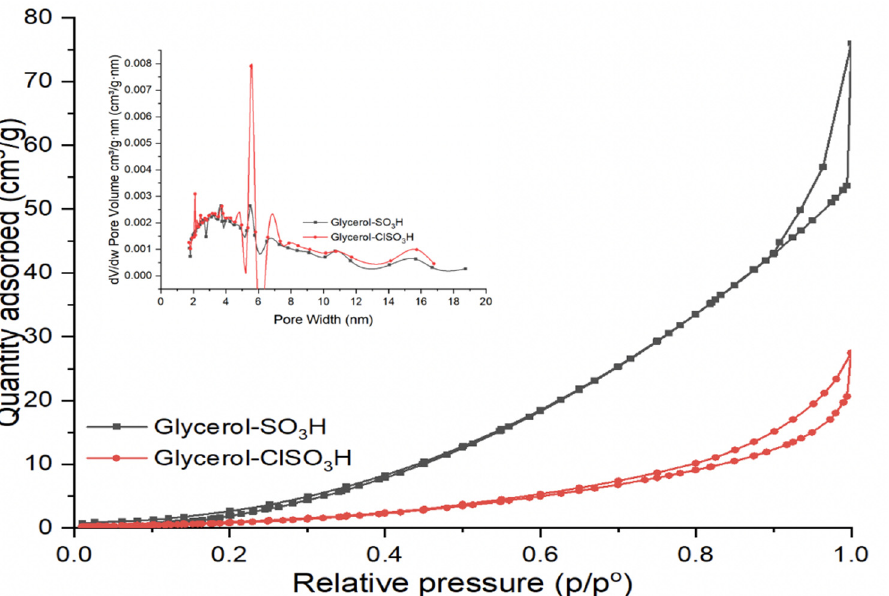
Figure 4. N 2 adsorption-desorption surface and pore diameter distribution of produced Glycerol- SO 3 H and Glycerol-ClSO 3 H catalyst.